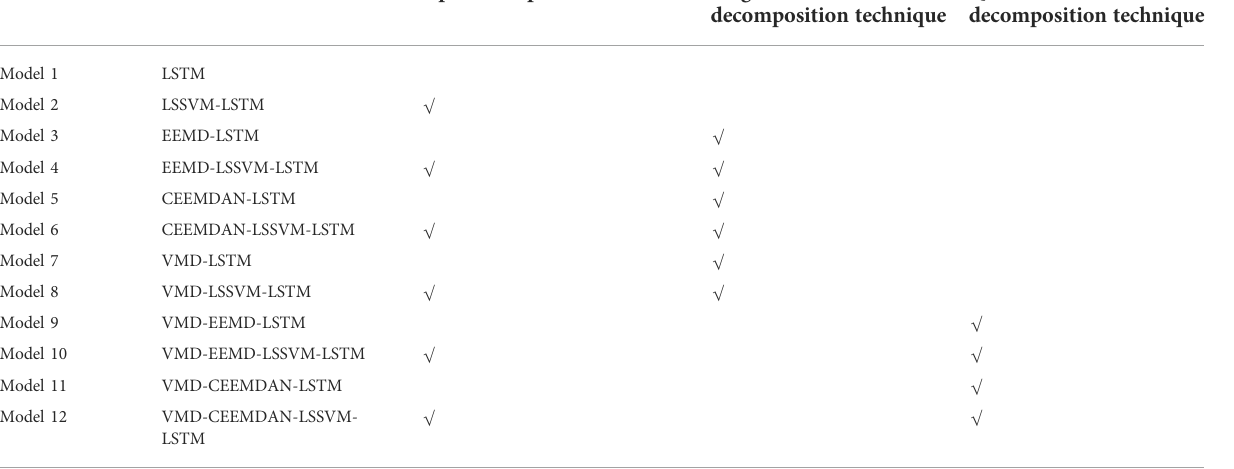
TABLE 3 Characteristics of different models. Model number Model